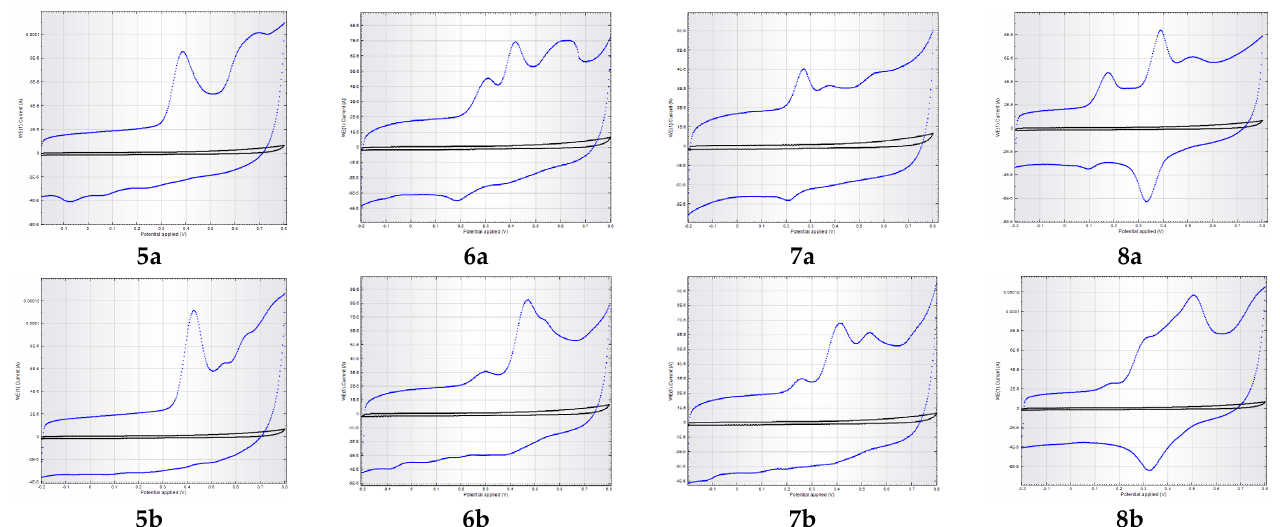
Figure 2. CVs for solutions of the novel synthesized compounds (blue) prepared in 0.1 M HClO 4 on graphite-based SPE. Black line: CV recorded in 0.1 M HClO 4 .